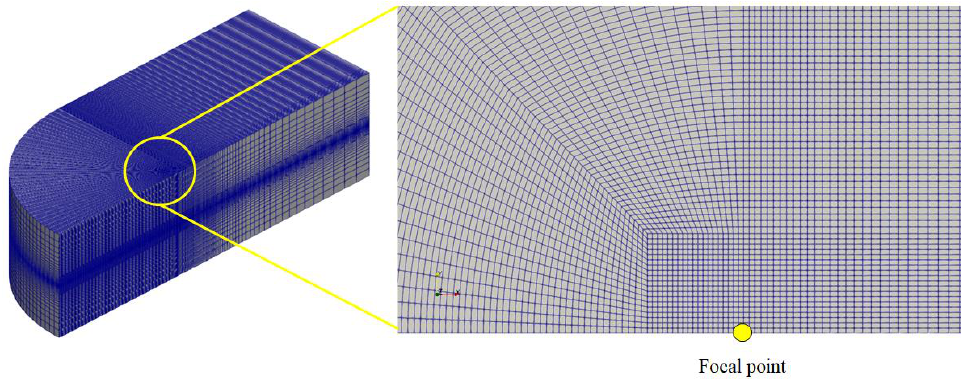
Figure 5. Typical surface meshes and focal point of a bull’s -eye waves simulation.